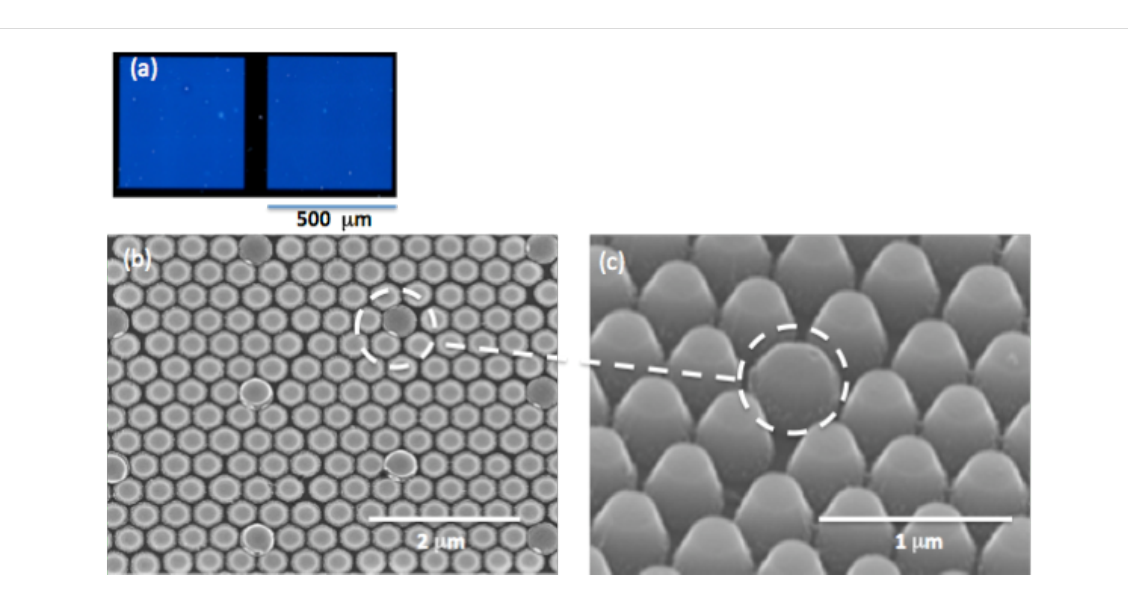
Figure 5: Nanomastering after a direct transfer by using RIE etching: (a) optical view (dark field) of the pre-patterned area (500 × 500 µm 2 ), (b) and (c) master top and 45° tilted SEM views, respectively. Pre-patterned post leads to slightly higher structures as highlighted by the dashed